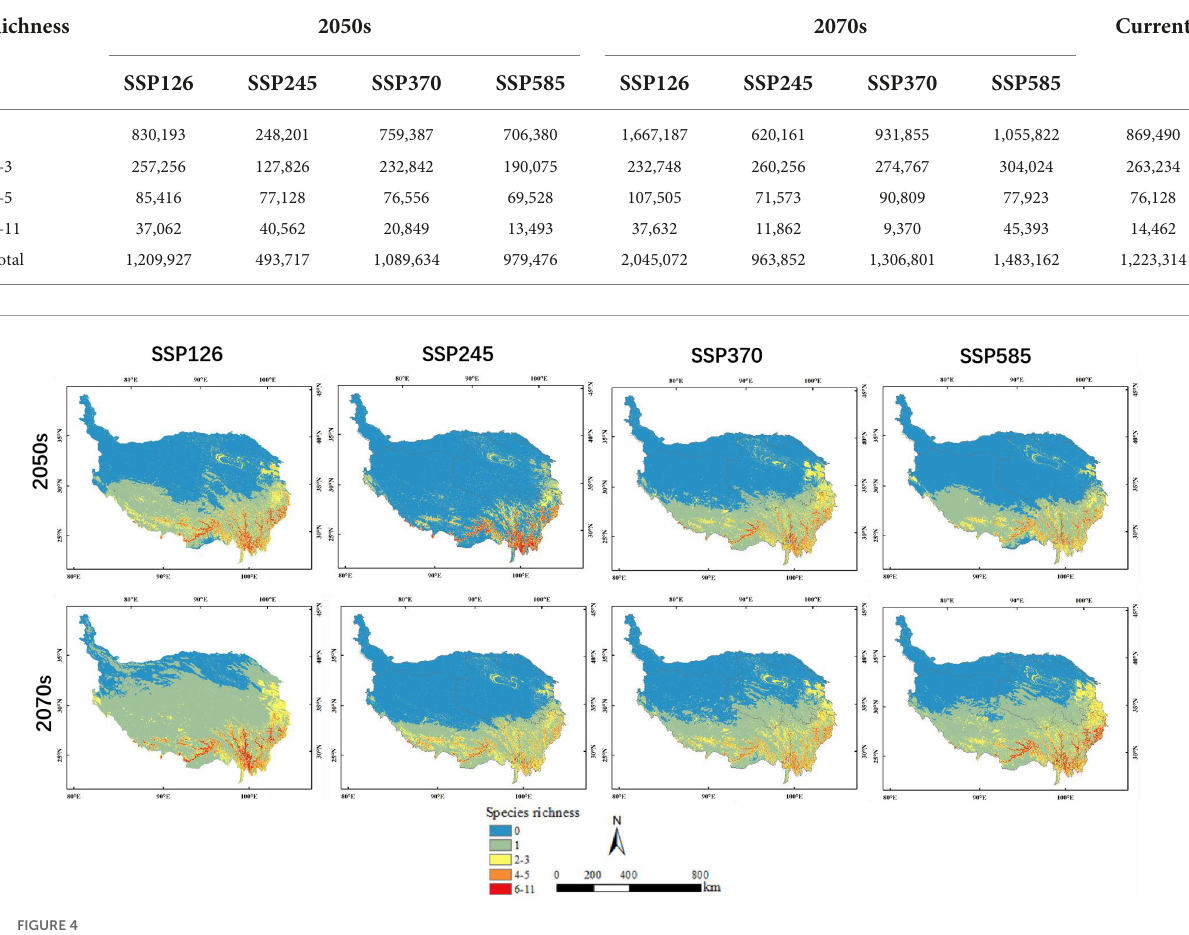
TABLE 5 The area (km 2 ) of orchid species richness under different climate scenarios.